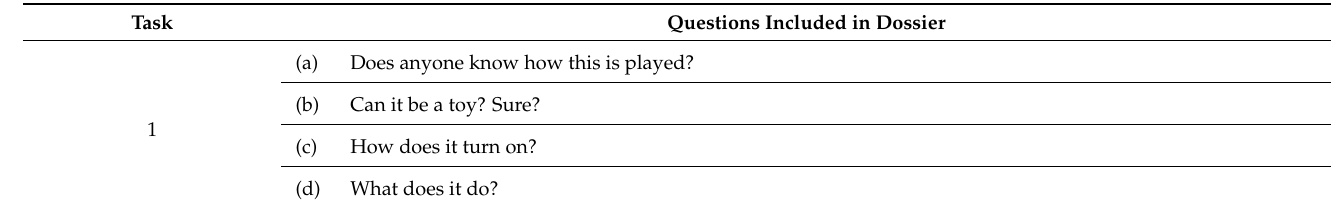
Table 3. Questions for each task included in the